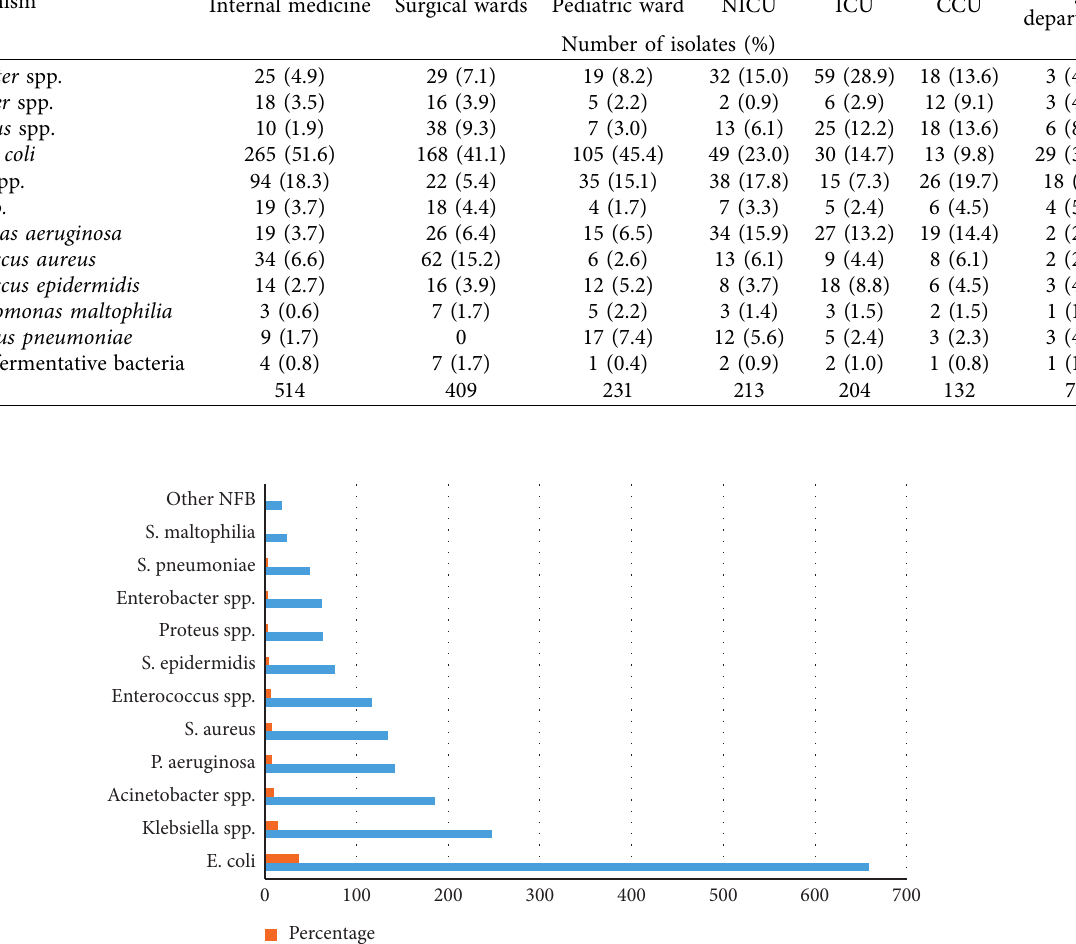
ETT: endotracheal tube specimen. Table 2: Distribution of bacteria isolated from patients with infections in different hospital wards. Microorganism Acinetobacter spp . Enterobacter spp . Enterococcus spp.